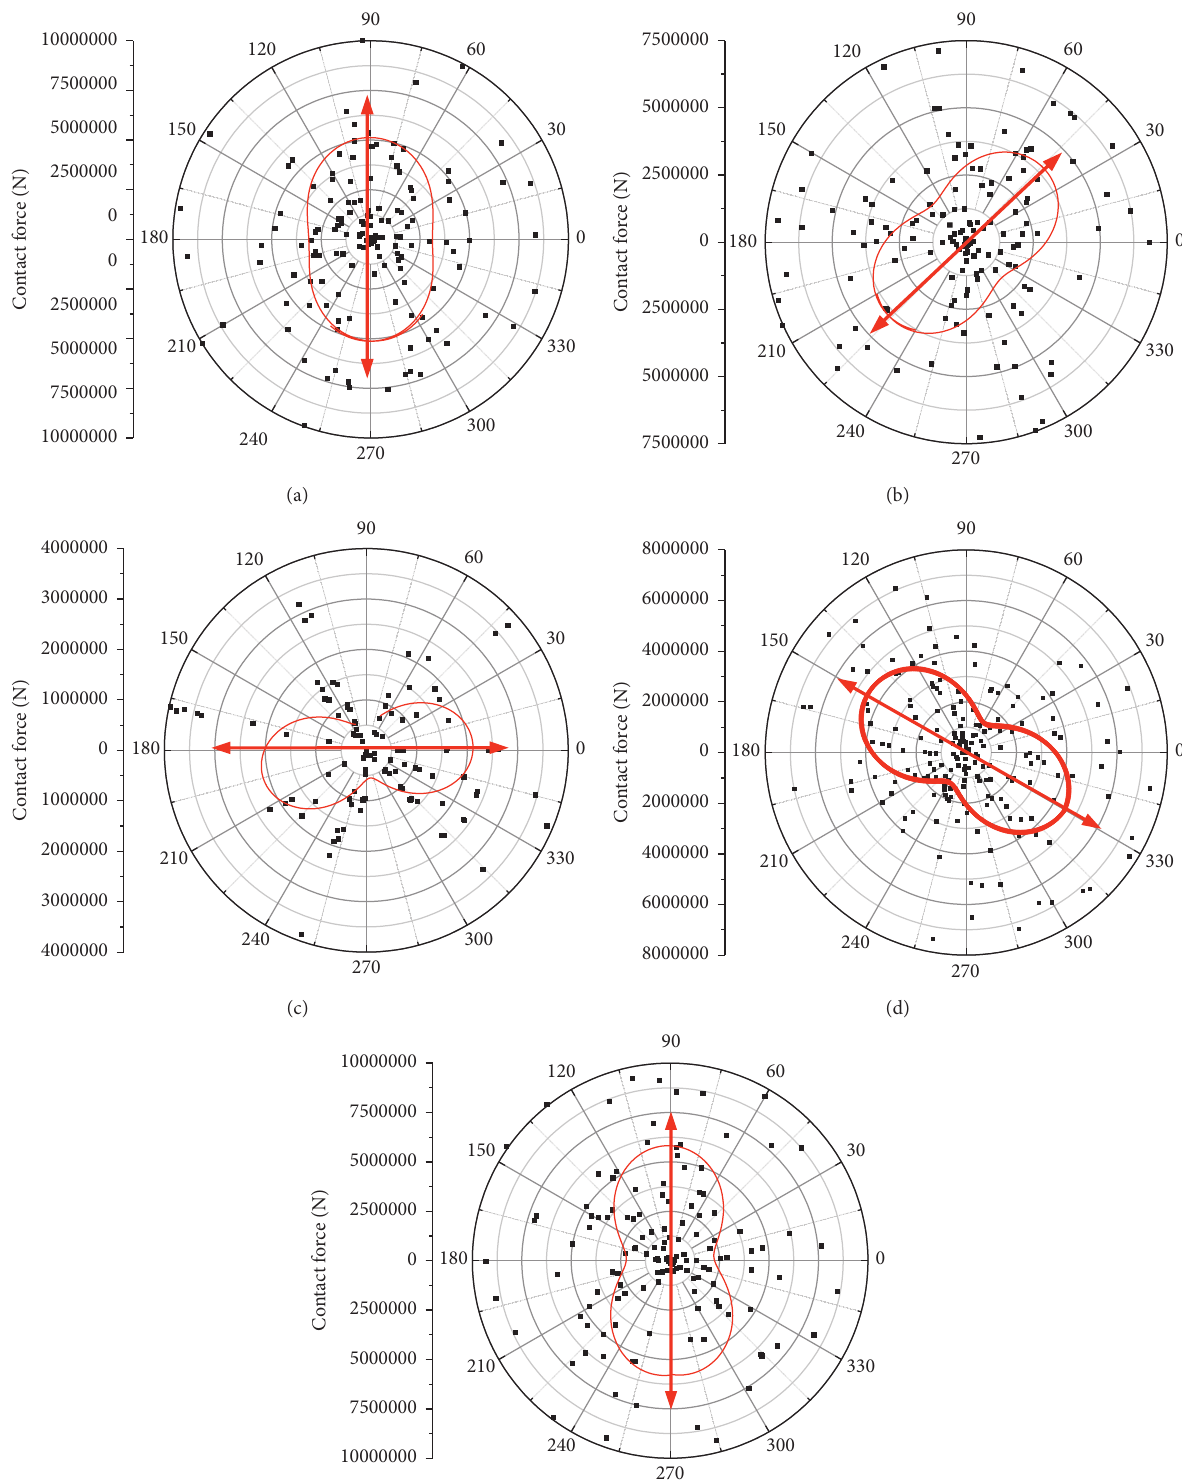
Figure 11: Fitting of the sizes and azimuth of the contact force chains in the designated areas of inclined surrounding rock masses along the working face. (a) Location A. (b) Location B. (c) Location C. (d) Location D. (e) Location